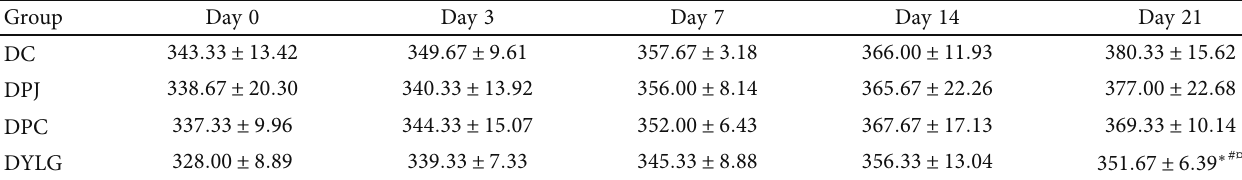
Table 1: The body weight/kg in T2DM rats on days 0, 3, 7, 14, and 21 ( n = 24 per group). Group Day 0